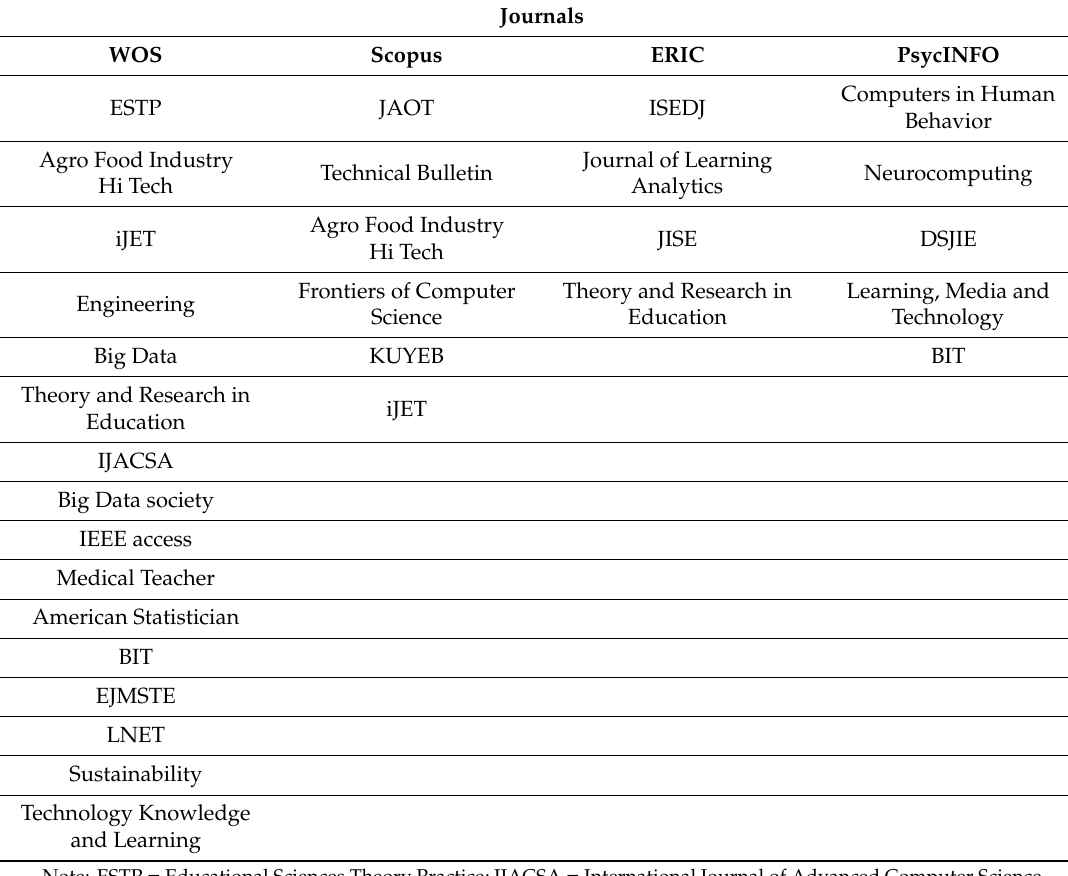
Table 2. Journals that make up the centre in WOS, Scopus, ERIC and PsycINFO. Journals WOS Scopus ERIC PsycINFO Computers in ISEDJ